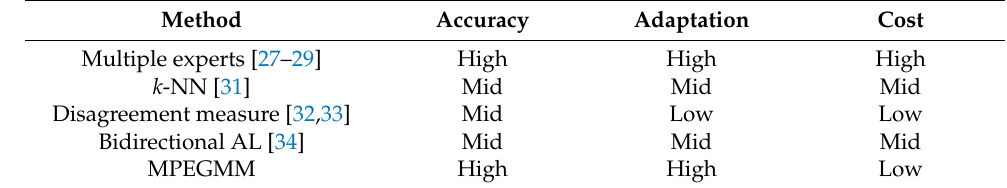
Table 1. Comparison between mislabel probability estimation method based on a Gaussian mixture model (MPEGMM) and other methods.